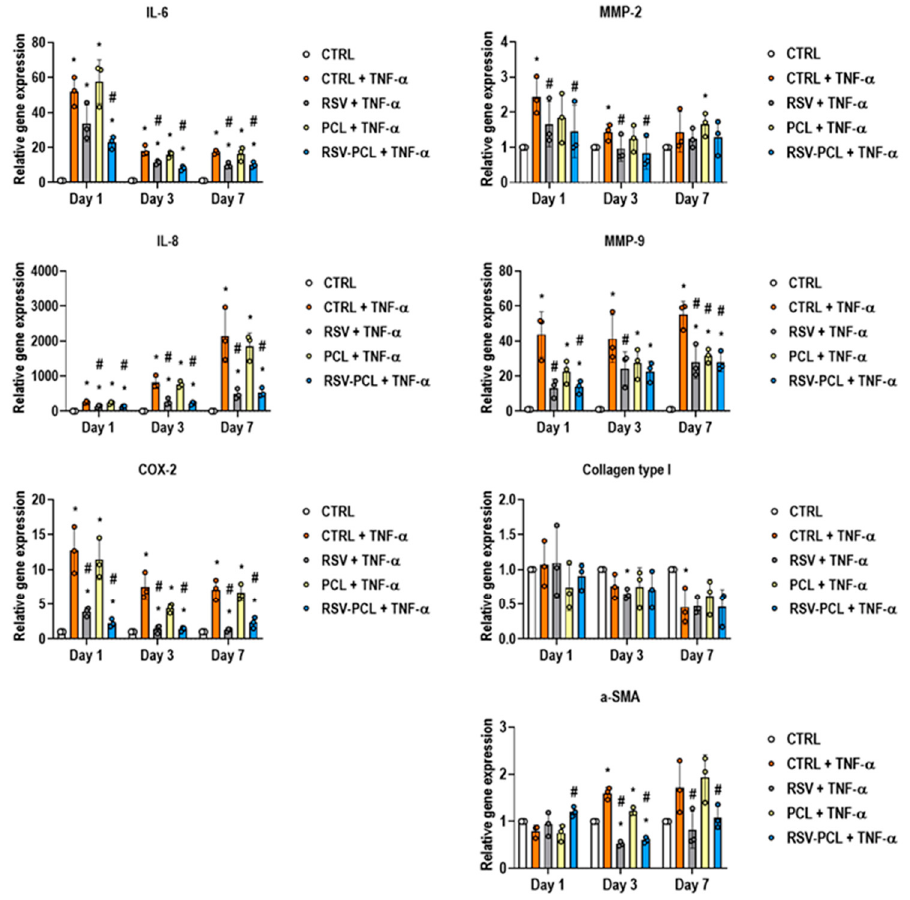
Figure 6. Effect of 0% RSV-PCL (PCL) and 10% RSV-PCL (RSV-PCL) electrosprayed microparticles on gene expression of human dermal fibroblasts. RT-qPCR analysis ( n = 3) revealed that, at all time points (1, 3, and 7 days), RSV-PCL microparticles (100 μ g/mL) significantly ( p < 0.05) reduced the expression of the inflammatory mediators IL-6, IL-8, COX-2 in comparison to cells treated with TNF- α (50 ng/mL). RSV-PCL microparticles significantly ( p < 0.05) reduced the expression of the ECM remodeling enzymes MMP-2 (at 1 and 3 days) and MMP-9 (at 1 and 7 days). No statistical differences ( p > 0.05) were observed in the expression of collagen type I, whereas RSV-PCL microparticles significantly ( p < 0.05) reduced the expression of α -SMA (at 3 and 7 days). Media containing 5 μ M RSV were used as positive controls. The results were normalized to untreated control (CTRL) cells at each time point. * indicates a statistically significant difference to the CTRL group at each time point ( p < 0.05). # indicates a statistically significant to CTRL + TNF- α group at each time point ( p < 0.05). Individual values are displayed as dots on bar charts. Error bars represent mean ± SD. Generalized linear models and bootstrap- t -tests.